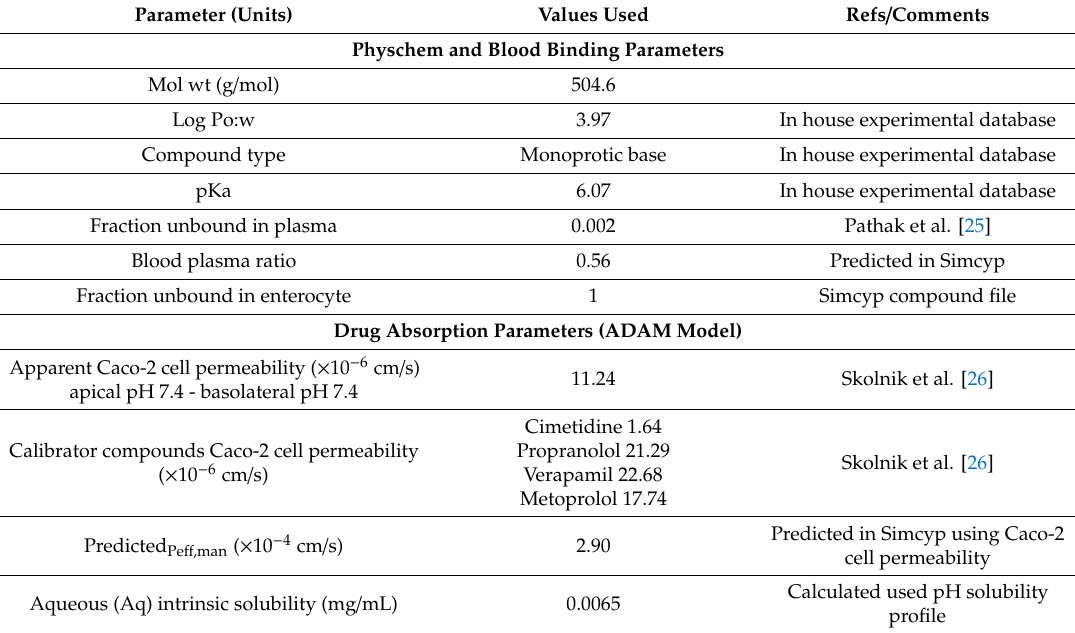
Table 1. Values of physicochemical and pharmacokinetic parameters used in physiologically based pharmacokinetic (PBPK) models for dipyridamole in the present